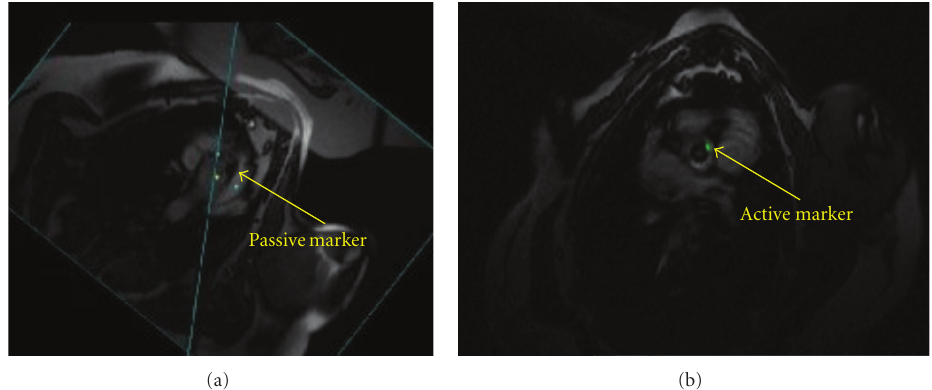
Figure 2: (a) Passive marker showing black signal in MRI. (b) Active marker showing bright signal and highlighted in green. These markers are used to indicate the orientation of the prosthesis in an MRI-guided aortic valve implantation